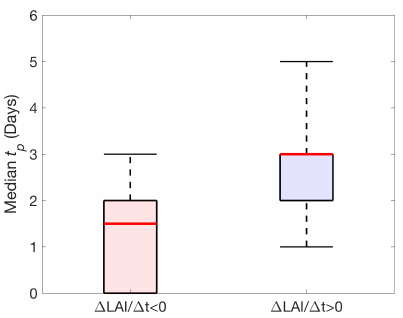
Figure 4. Relationship of plant water content increase timescales with biomass changes in African regions with median t p ≥ 1d. Growth increases the timescale of plant water content. Mann– Whitney U tests indicate that the medians of the two bins are sig- nificantly different ( p < 0 .